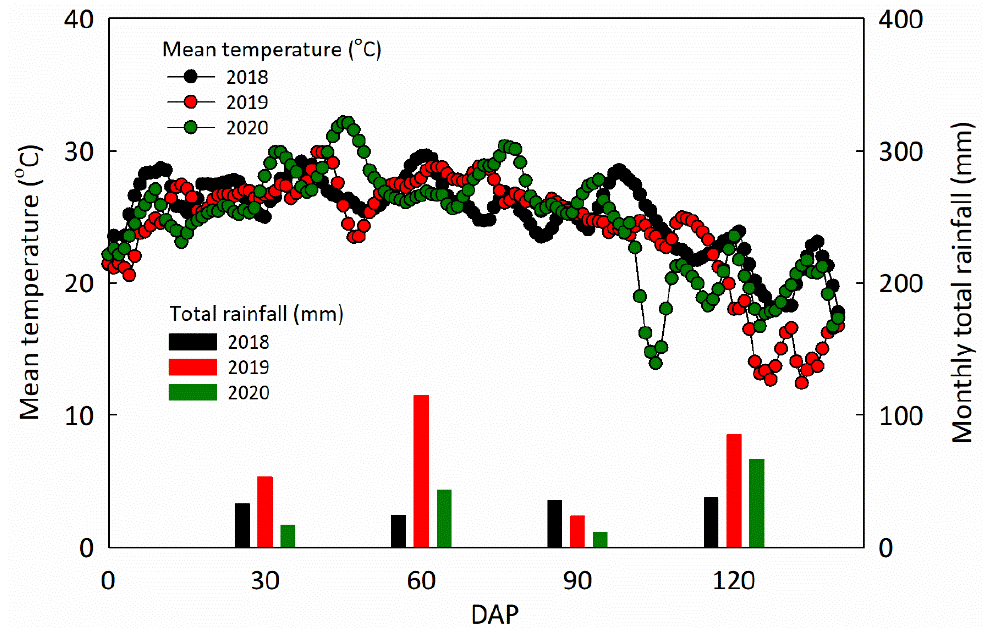
Figure 1. Mean temperatures by days after planting (DAP) and monthly total rainfall during the 2018, 2019, and 2020 growing seasons at Texas Tech University Research Farm, New Deal, TX, USA. For each year, the experiment was laid out in a split plot randomized complete block design with cultivars as main plots and N fertilizer rates as subplots, with four replicates. Each plot has eight 7.62 m long rows and rows were spaced 1.02 m apart. Cotton cultivars FiberMax 958 LL (FM 958; PI 642049) and Deltapine 1646 B2XF (DP 1646) were planted on 21 May 2018, 31 May 2019, and 29 May 2020 at an average density of 13.0 plants m −2 . Five